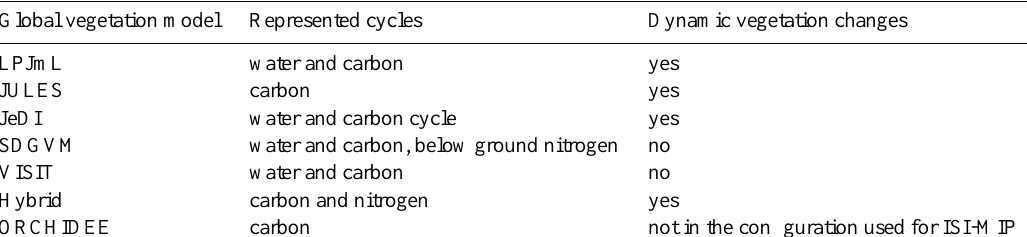
Table 3. Short characterisation of the applied biome models. More details are provided in Sect. 6 in the Supplement.